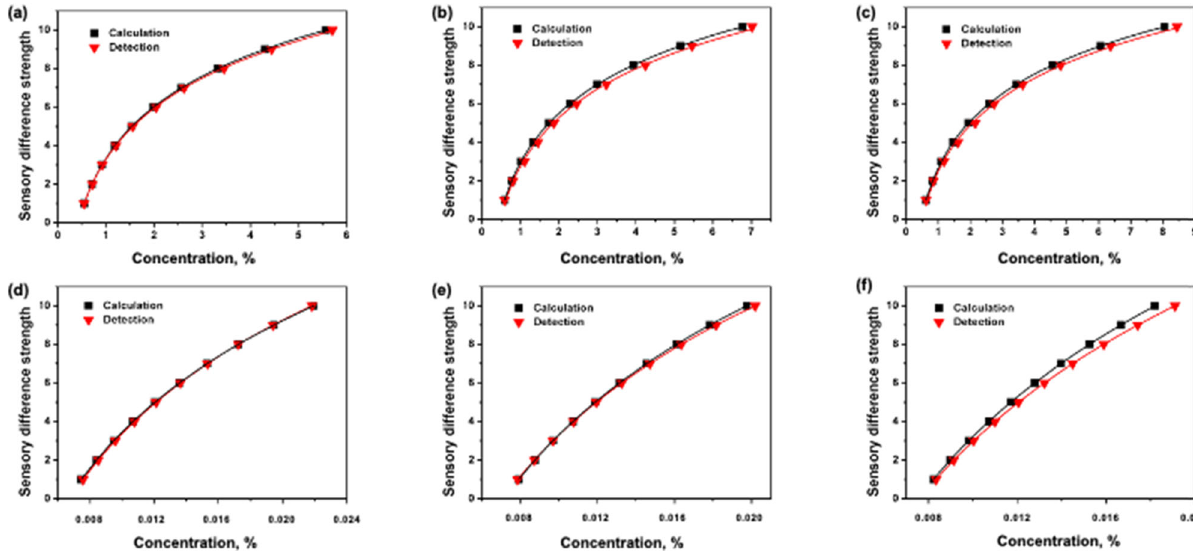
Fig. 3 Sweet and sour taste sensory strength variation models veri fi cation comparison results. a Showed the sweet sensory difference strength of sucrose in 0.0095% of citric acid solution; b showed the sweet sensory difference strength of sucrose in 0.0105% of citric acid solution; c showed the sweet sensory difference strength of sucrose in 0.0115% of citric acid solution; d showed the sour sensory difference strength of citric acid in 1.5% of sucrose solution; e showed the sour sensory difference strength of citric acid in 3% of sucrose solution; f showed the sour sensory difference strength of citric acid in 5% of sucrose